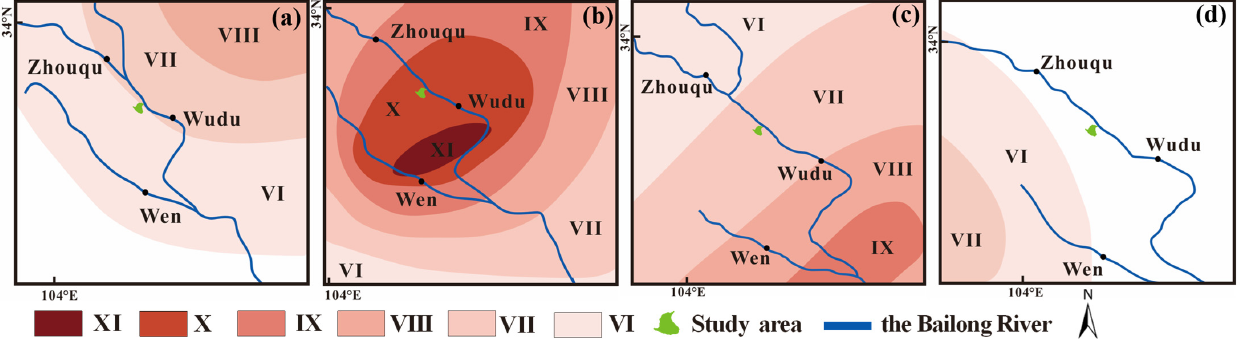
Figure 4. The intensity of different earthquakes in the study area. ( a ) The intensity of the 1654 Lixian earthquake (Adapted with permission from Ref. [54]. 2017, Yuan et al.); ( b ) the intensity of the 1879 Southern Wudu (Wenxian) earthquake (Adapted with permission from Ref. [55]. 2014, Yuan et al.); ( c ) the intensity of the 2008 Wenchuan earthquake (the data comes from the China Earthquake Administration); ( d ) the intensity of the 2017 Jiuzhaigou earthquake (the data comes from the China Earthquake Administration).